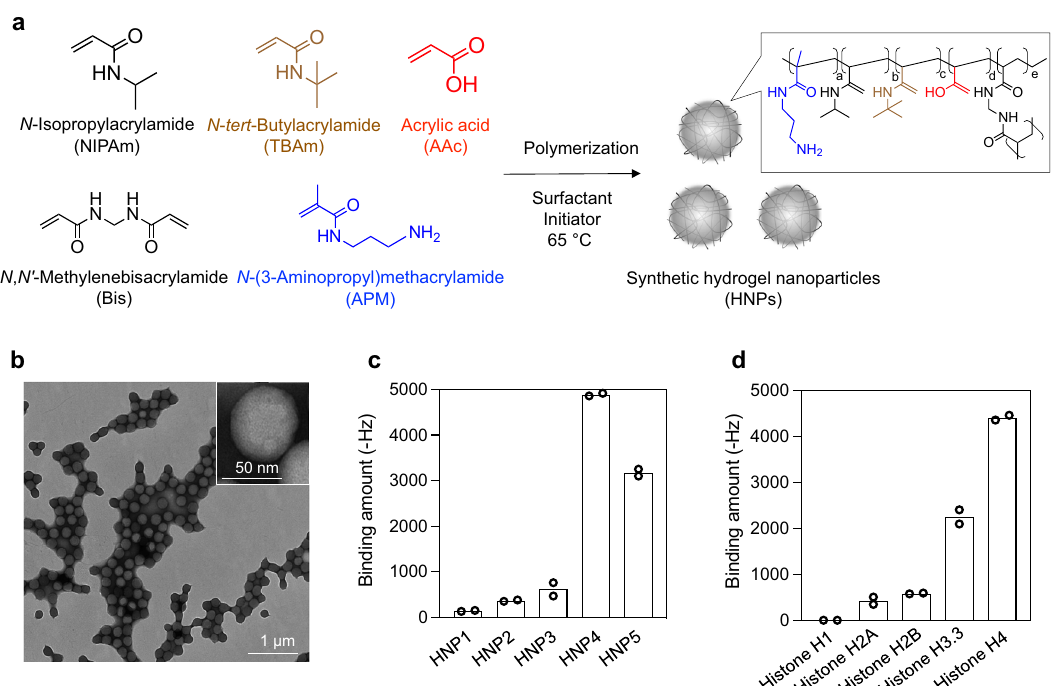
Fig. 2 Screening of HNPs for histone af fi nity. a Schematic of synthetic HNPs synthesized by free-radical copolymerization of functional monomers. b TEM image of HNPs. The experiment was repeated three times. c Af fi nity of HNPs for histones. QCM sensor cells were functionalized with histones. After blocking with BSA, each type of HNPs was added and their binding amount was measured. d Af fi nity of HNP4 for the puri fi ed histone subtypes. QCM sensor cells were functionalized with the puri fi ed histone subtypes. After blocking with BSA, HNP4 was added and its binding amount was measured. Data represent the means of independent duplicate measurements. Table 1 Monomer composition, size, zeta-potential, and PDI of HNPs.